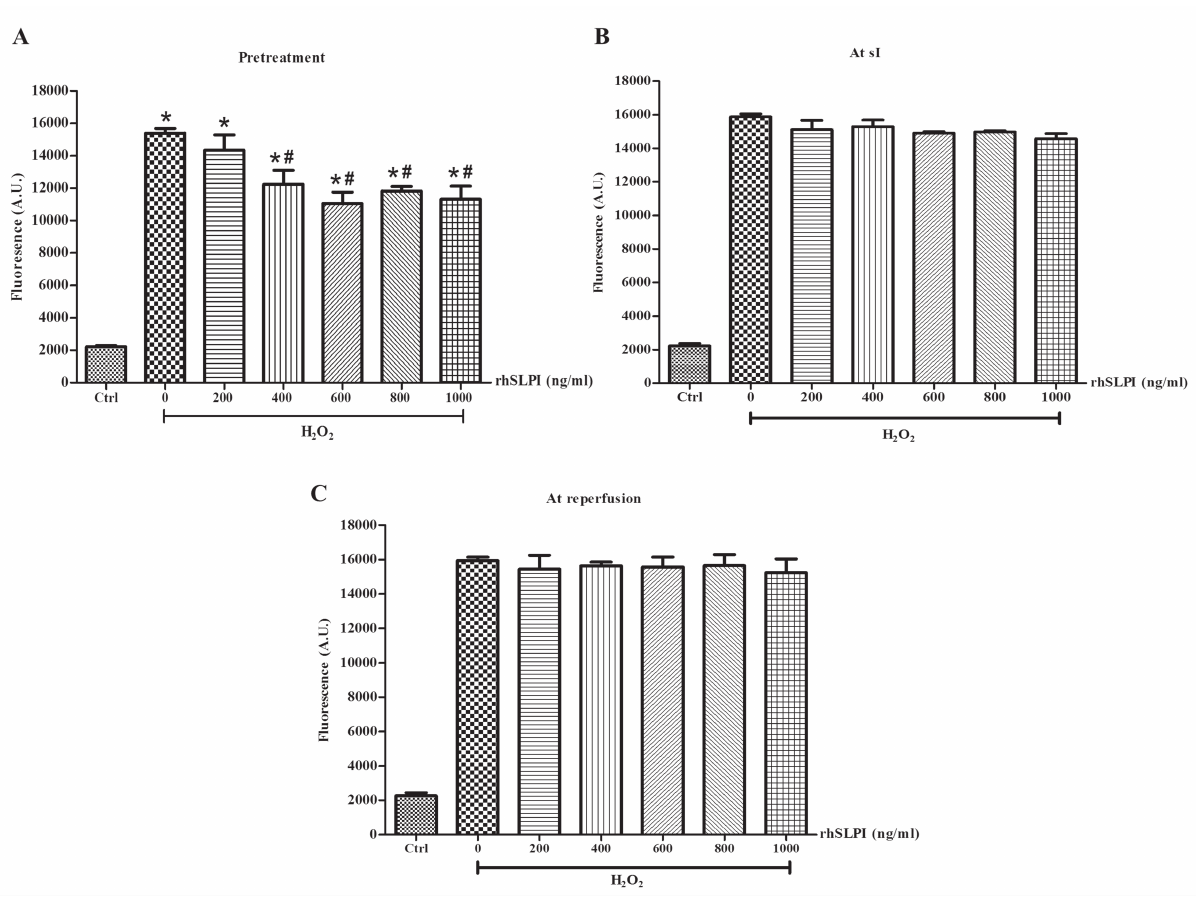
O . H9c2 cells were incubated with carboxy- 2 2